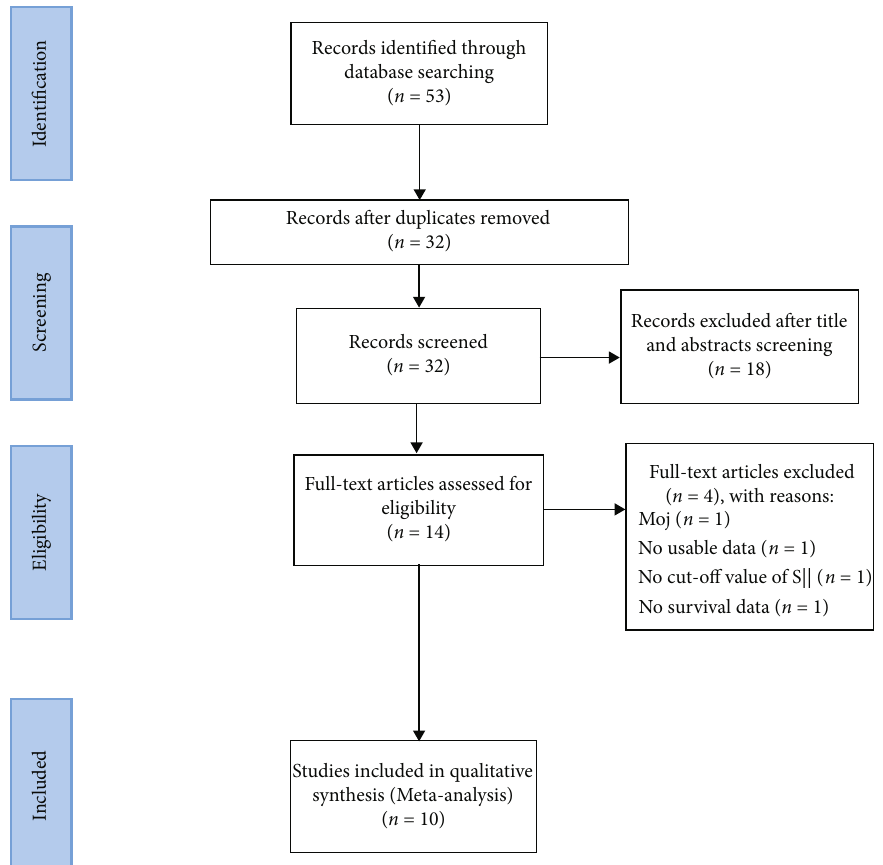
Figure 1: Flow chart of literature search and study